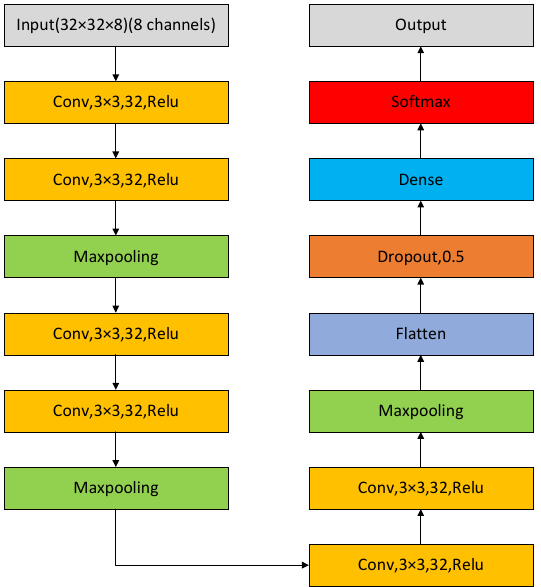
Figure 7. The structure of 2D CNN network.